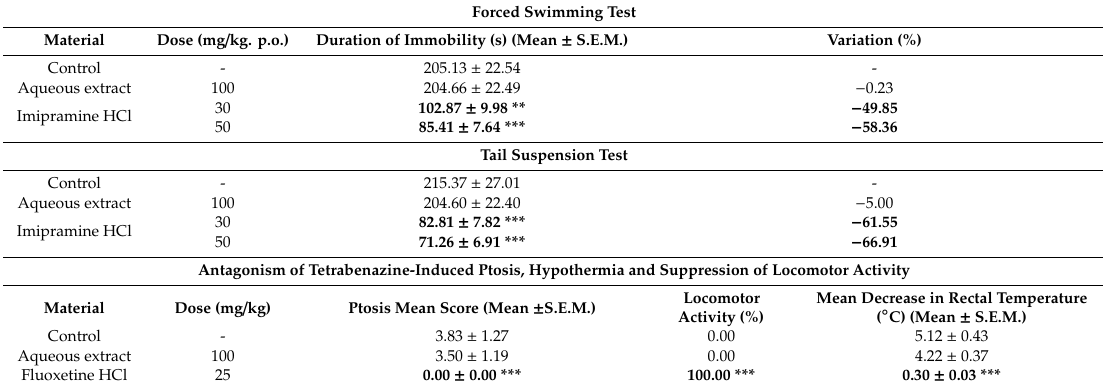
Table 1. E ff ects of the aqueous extracts prepared from the aerial parts of Lotus corniculatus L. subsp. corniculatus in the antidepressant activity